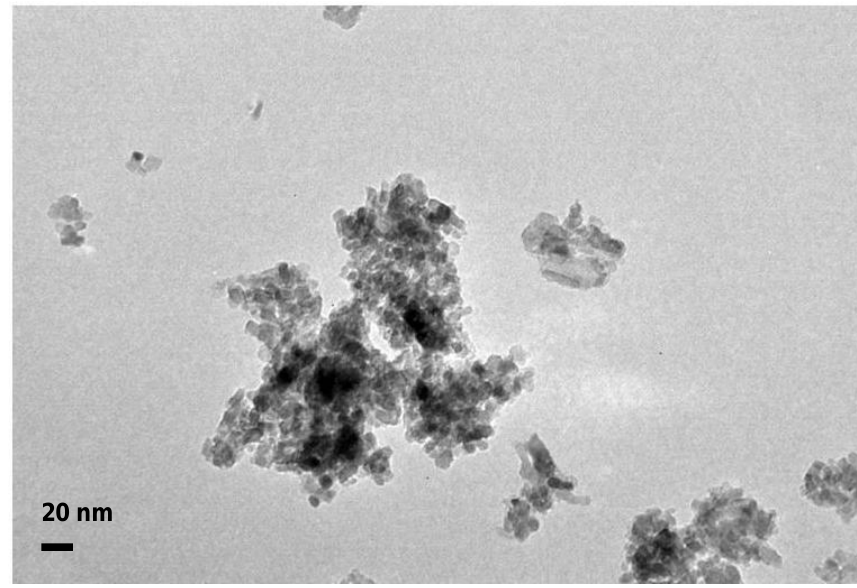
Figure A9. Microphotography of Ru/Al 2 O 3 -Mg(10 wt%) catalyst.